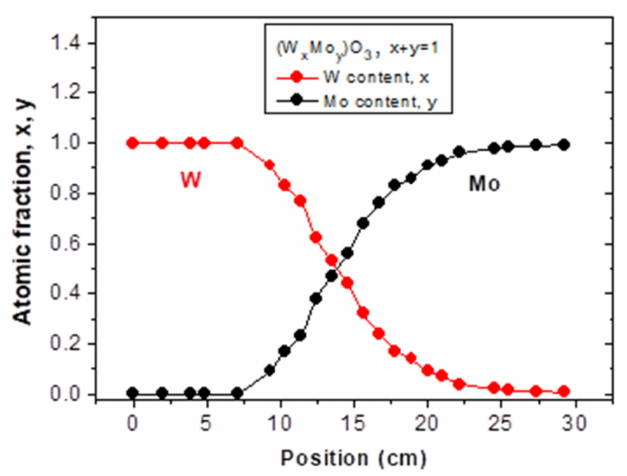
Figure 10. Photograph of one sample (left). Photograph of the Si-probes, which were placed at the center line of some samples for RBS and XRD (center). One Rutherford Backscattering Spectrometry example near the center position.